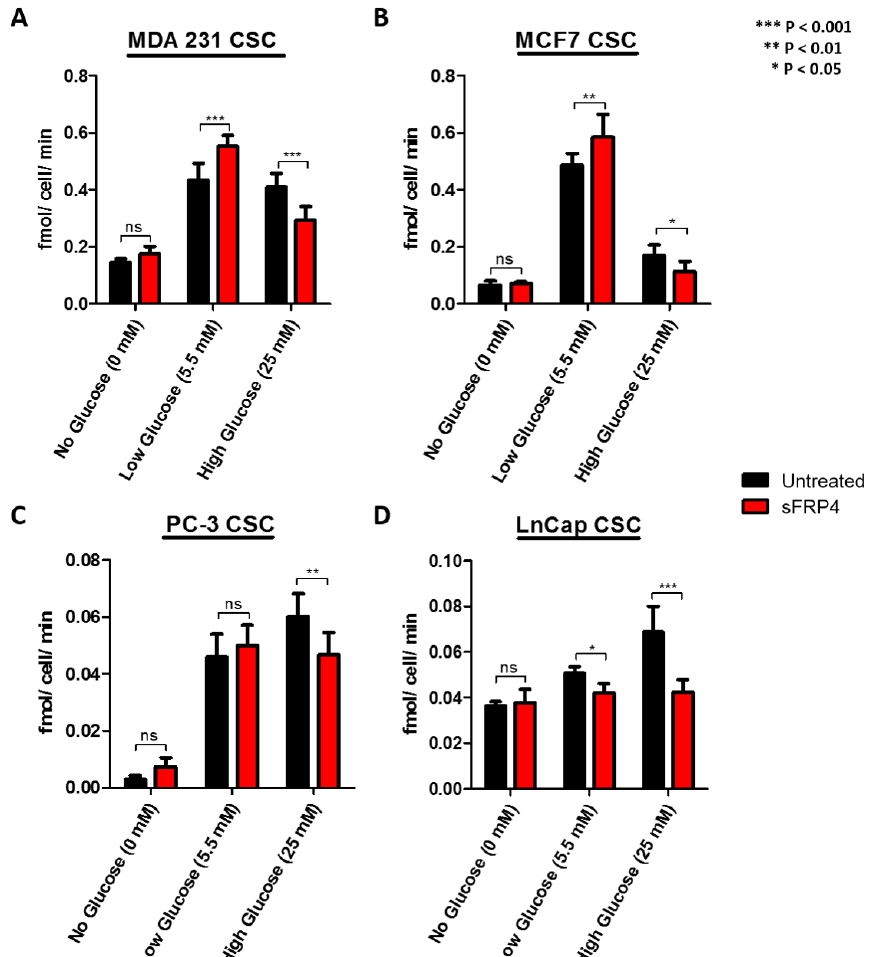
Fig4 Figure 4. The effect of sFRP4 on glucose-uptake in CSCs: CSCs were isolated in various glucose concentrations and treated with sFRP4 (250 pg) for 24 h. Cellular uptake was detected with Glucose Uptake-glo assay. ( A ) MDA231 CSCs; ( B ) MCF7 CSCs; ( C ) PC-3 CSCs; and ( D ) LnCap CSCs. Statistical analysis was performed using ANOVA for analysis variance with Bonferroni test for comparison showing significance as *** p < 0.001; ** p < 0.01; * p < 0.05. Data are mean ± standard error of mean from three independent